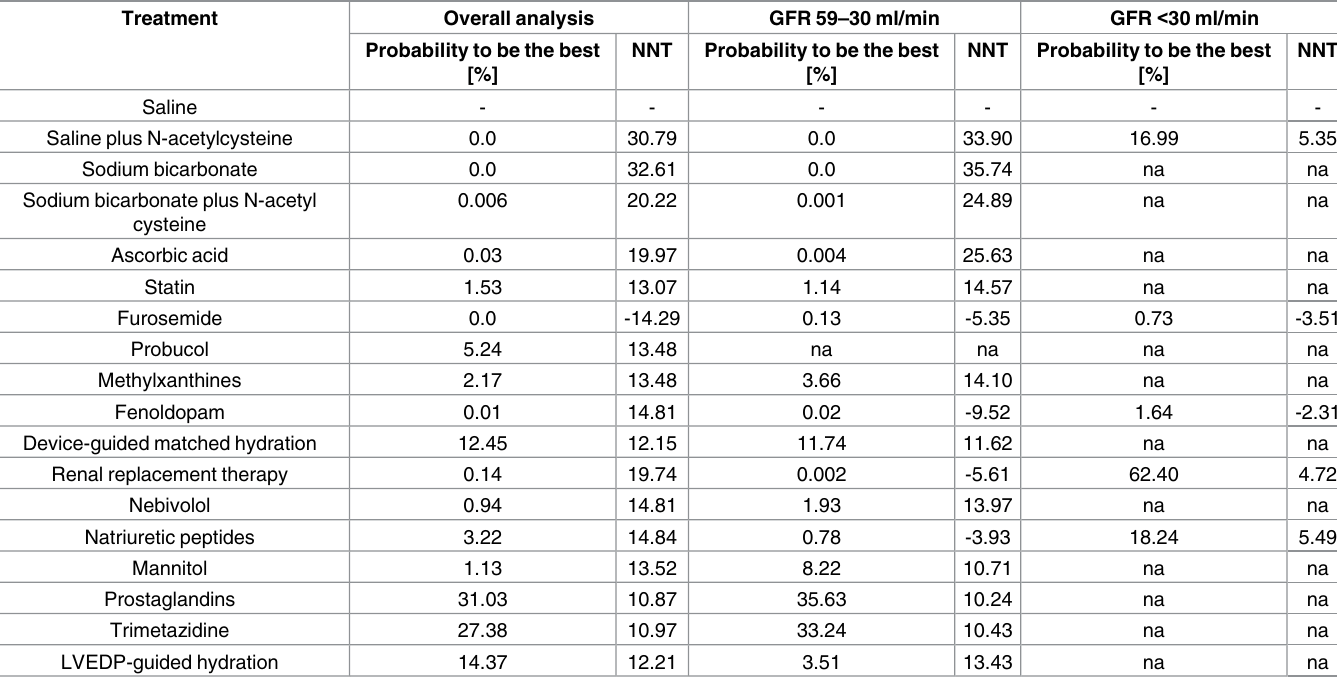
Table 1. Overall and GFR stratified analysis for CIAKI prevention, with